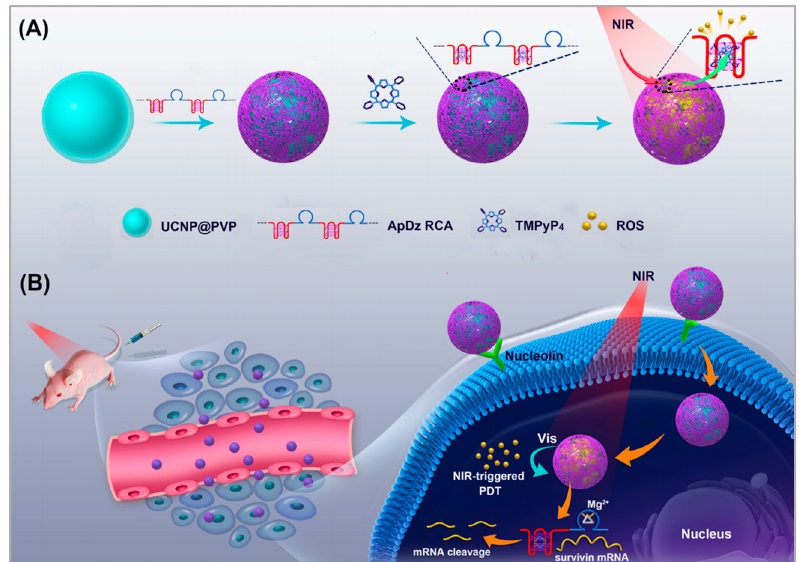
Figure 4. Illustration of: ( A ) the synthesis of the multifunctional DNA polymer-assisted upconversion therapeutic nanoplatform; and ( B ) the targeted photodynamic nanoplatform for highly efficient photodynamic therapy. Reprinted with permission from [88]. Copyright © 2020 American Chemical